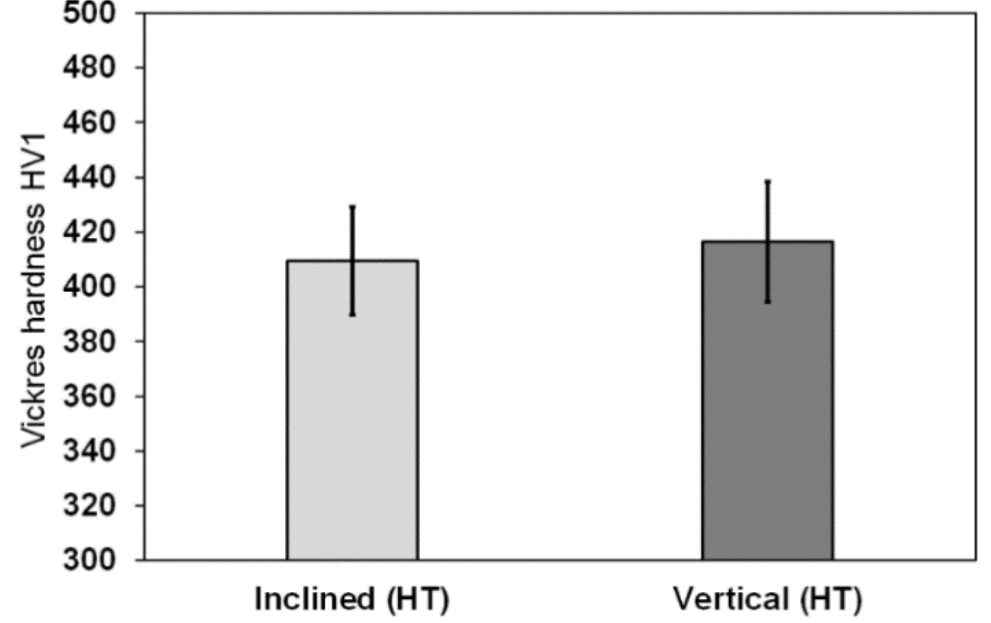
Figure 10. The micro-hardness for the heat-treated vertical and inclined struts.